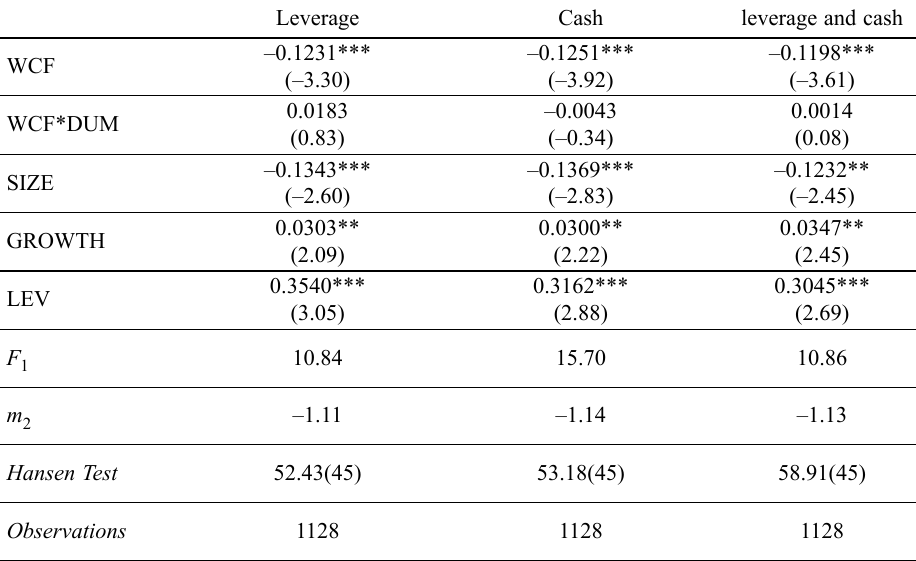
Table 6. Financing of working capital requirement and financial flexibility (2008–2012) Leverage Cash leverage and